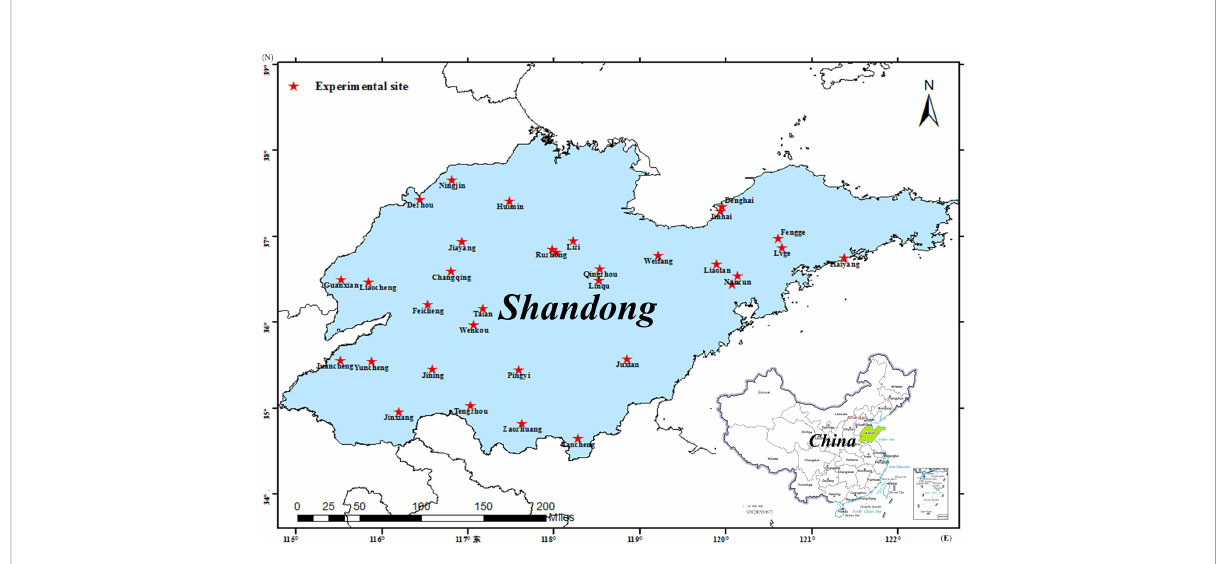
FIGURE 1 Distribution of experiment sites. The red star represents the experiment